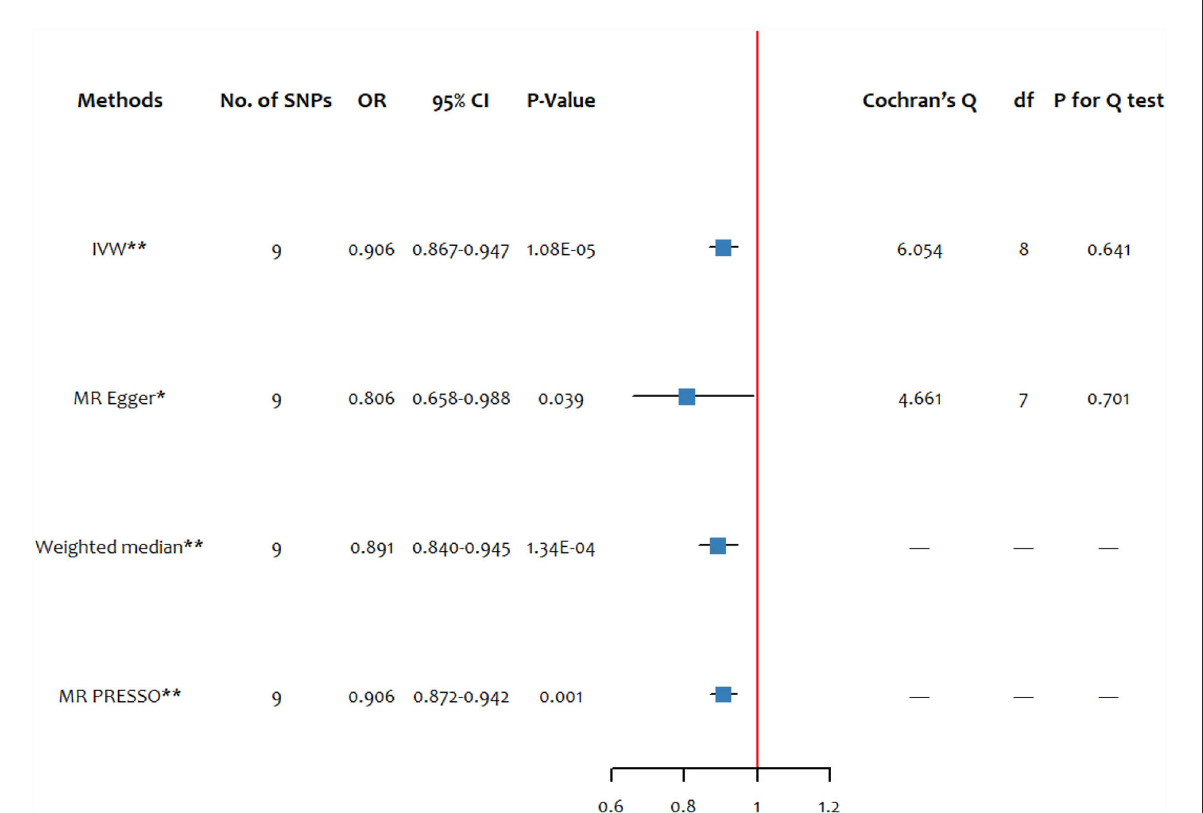
FIGURE1 The forest plots of MR estimates and the Cochran’s Q-test for the blood selenium level on schizophrenia. SNP, single-nucleotide polymorphism; df, degree of freedom; IVW, inverse variance weighted; MR-PRESSO, MR pleiotropy residual sum and outlier. * significant at p < 0.05, ** significant at p <